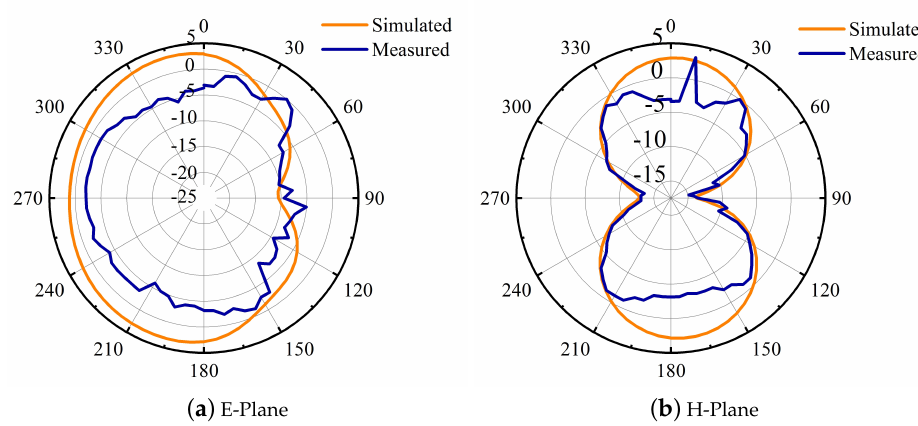
Figure 26. The measured and simulated far-field pattern for E and H plane at 5.2